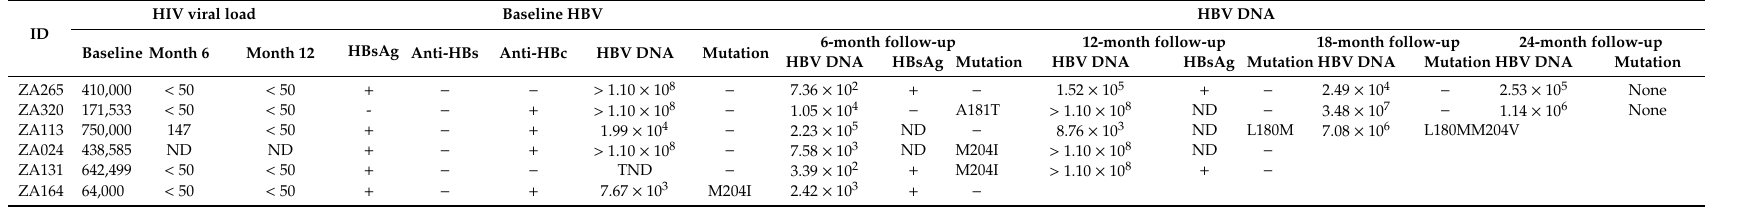
Table 5. Profile of patients with / without mutations and persistent HBV DNA from baseline to 24